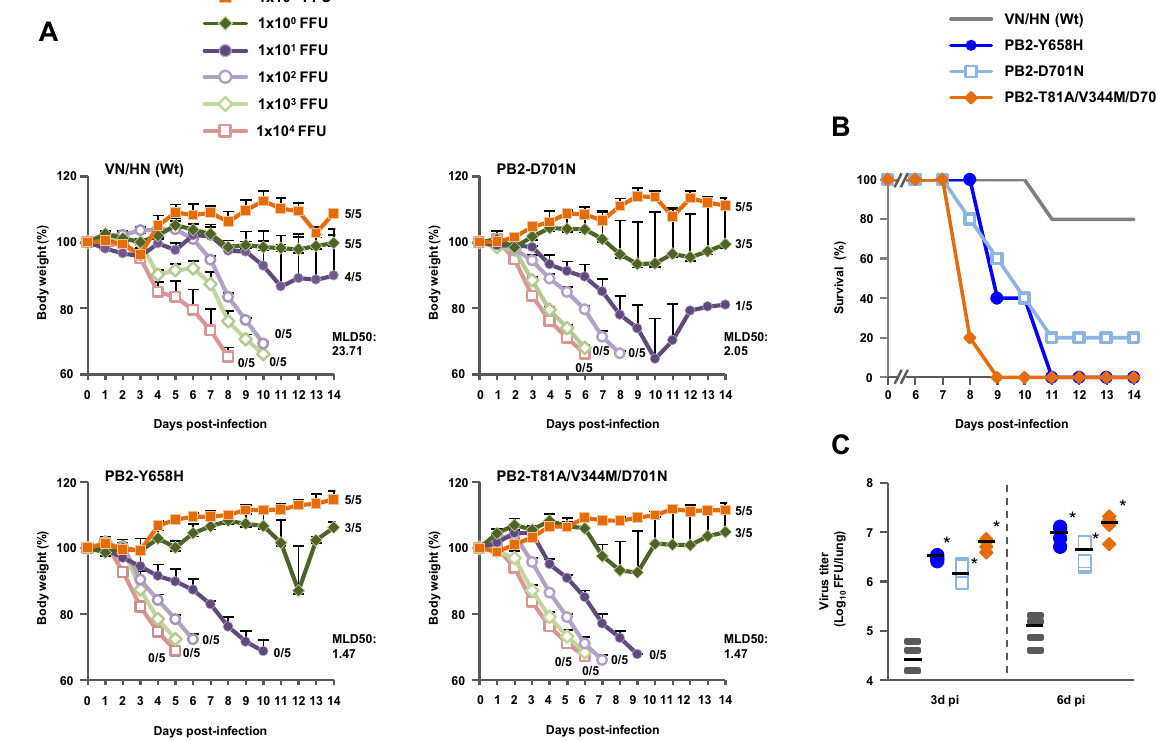
Figure 6. Effect of H5N1 polymerase mutations on mortality and weight loss of infected mice. Five-week-old BALB/c mice were inoculated intranasally with serial 10-fold dilutions of the indicated VN/HN viruses. ( A ) Body weight of mice (5 mice per group) infected with the indicated viruses was monitored for 14 d post-infection. The mean ± SD of the percent body weight change for each group of infected mice is shown. The numbers on the curves show the numbers of surviving animals. ( B ) Survival of mice (5 mice per group) infected with 10 FFU of the indicated viruses. Mortality was calculated including mice that were sacrificed after they had lost more than 30% of their body weight. ( C ) Effect of H5N1 polymerase mutations on virus yields in infected mice lungs. Virus titers in the lungs of five-week-old BALB/c mice (5 mice per group) infected with 100 FFU of the indicated VN/HN viruses were measured at 3 d (left) and 6 d (right) post-infection. Each symbol marks the titer in an individual mouse. An asterisk indicates a P value < 0.01 (ANOVA with Tukey’s multiple comparison